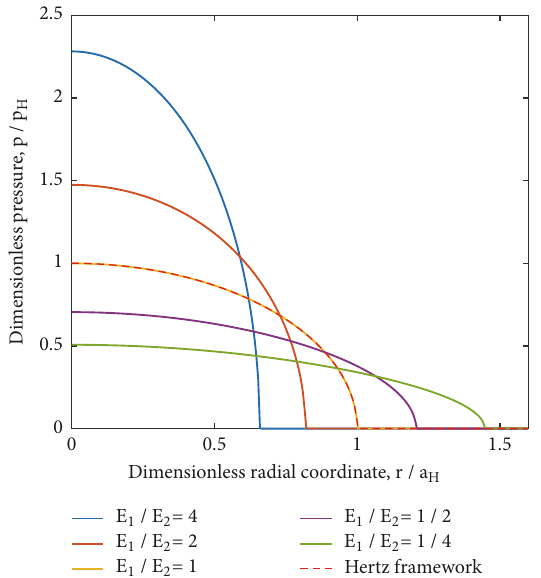
Figure 3: Radial pressure profiles in the spherical indentation of a coated half-space, ℎ/𝑎 𝐻 = 1 .